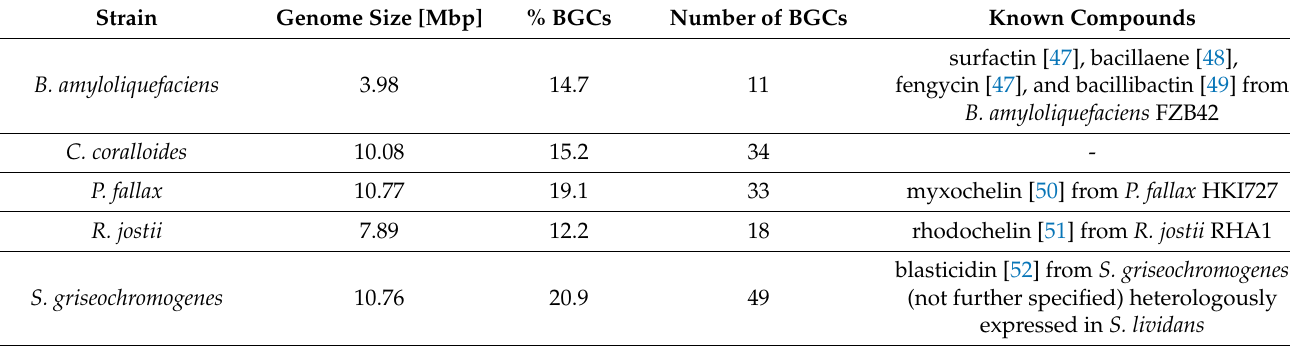
Table 3. Summary of the biosynthetic potential of the five selected strains based on the genome mining approach with antiSMASH. The percentage of detected biosynthetic gene clusters (BGCs) in the genome, the total number of BGCs, and the number of known secondary metabolite (SM) compounds of these selected bacteria are shown in the table.